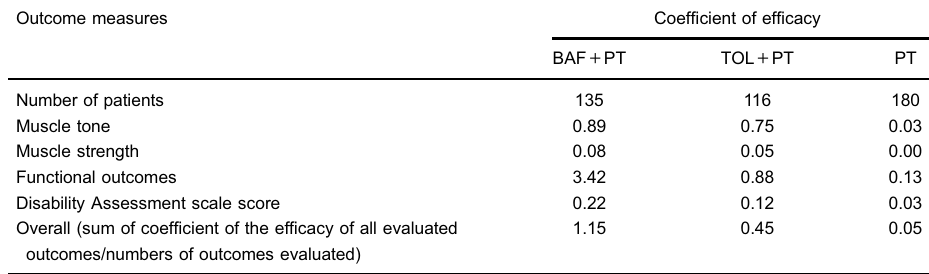
Figure 5. The Disability Assessment scale score of patients at different points of evaluation. A and B , 4 and 6 weeks after the start of interventions, respectively. *P o 0.05 compared to the PT group (ANOVA). BAF + PT: baclofen plus physical therapy; TOL + PT: tolperisone plus physical therapy; PT: physical therapy alone. Table 3. Coef fi cient of ef fi cacy 6 weeks after the start of interventions.